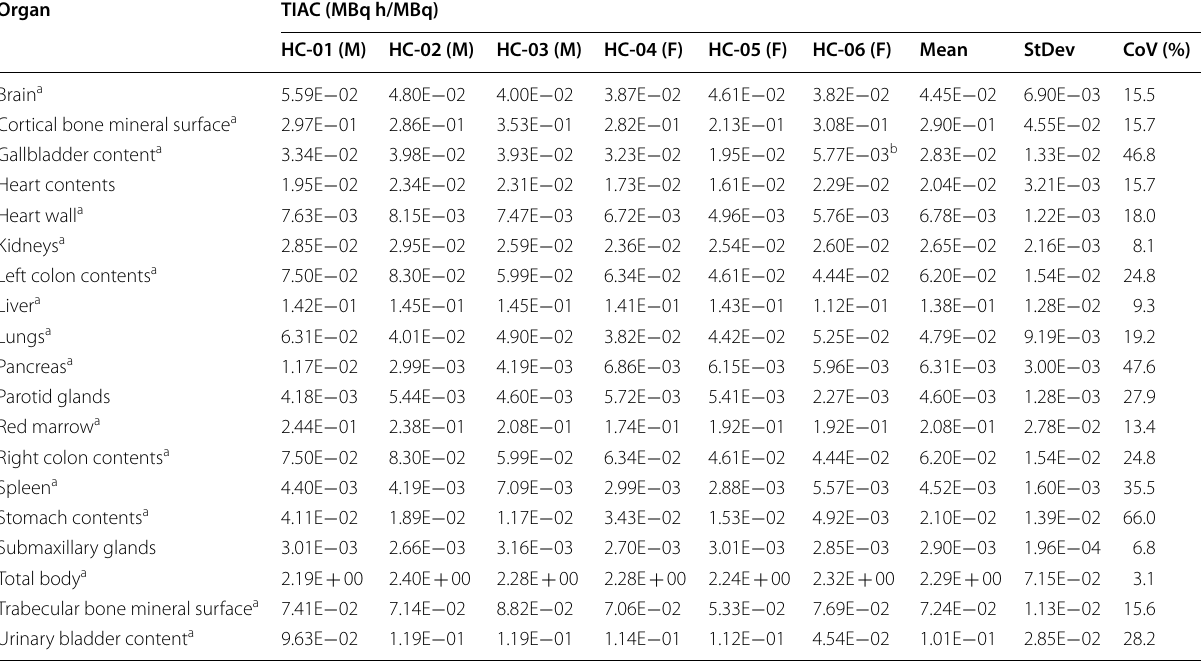
a Used as input for dose calculations in IDAC 2.1 b Subject underwent cholecystectomy prior to inclusion—activity uptake from bile